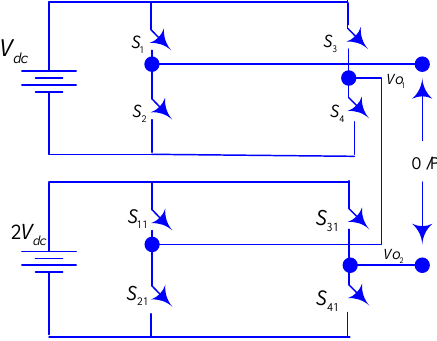
Figure 8. Five-level asymmetric hybrid MLI.